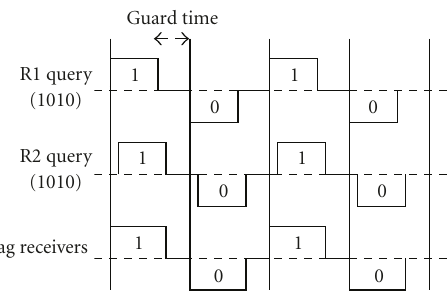
Figure 7: Bit level synchronization with guard time to make up for synchronization errors between readers. The above example is shown for the case when all readers want to send queries with bits 1010 to